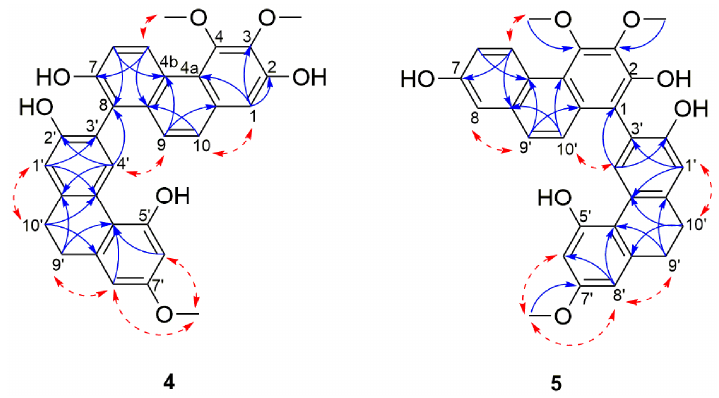
Figure 3. Selected NOESY (red dashed arrows) and HMBC (blue arrows) correlations of compounds 4 – 5 . Table 2. 1 H (500MHz) and 13 C (125 MHz), HMBC and NOESY spectroscopic data of compounds 4 – 5 ( δ in ppm, J in Hz) in acetone- d 6 .